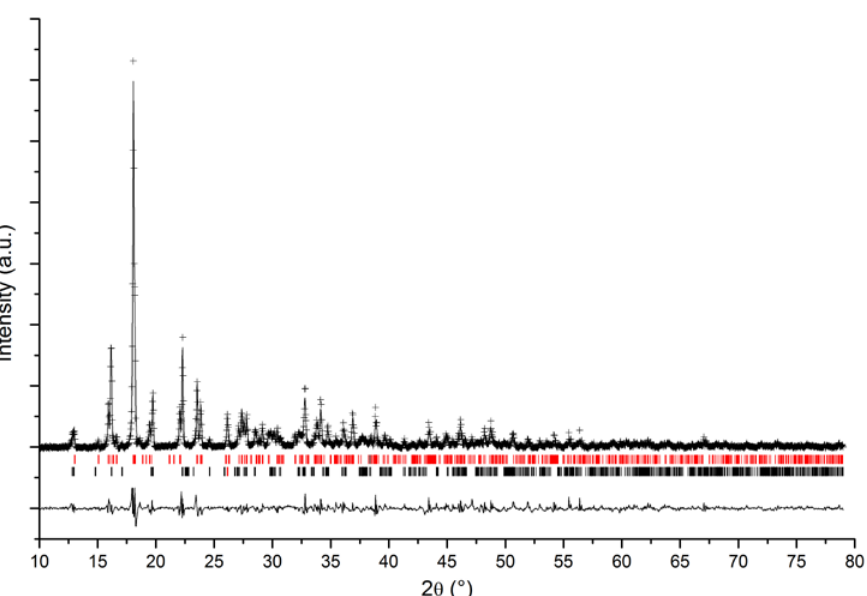
Figure 3. Rietveld refinement of the room temperature (RT) pattern of the studied melanterite sample in the 10–80 ◦ 2 θ range. Cross symbols indicate the observed data; solid line indicates the calculated pattern; the solid line at the bottom indicates the residuals; melanterite (red) and rozenite (black) peak positions.